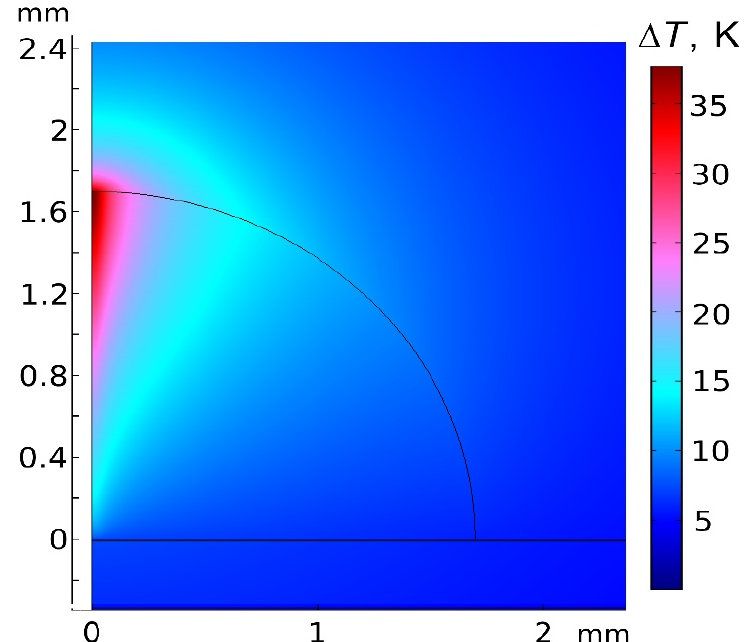
Figure 7. The simulated temperature increase distribution (with respect to the room temperature) resulting from laser heating in a sample drop (by a volume of 10 µ L) on a foil and in the surrounding air (in the axisymmetric geometry). The horizontal direction corresponds to the radial coordinate (the symmetry axis is perpendicular to the foil plane and coincides with the laser beam axis).